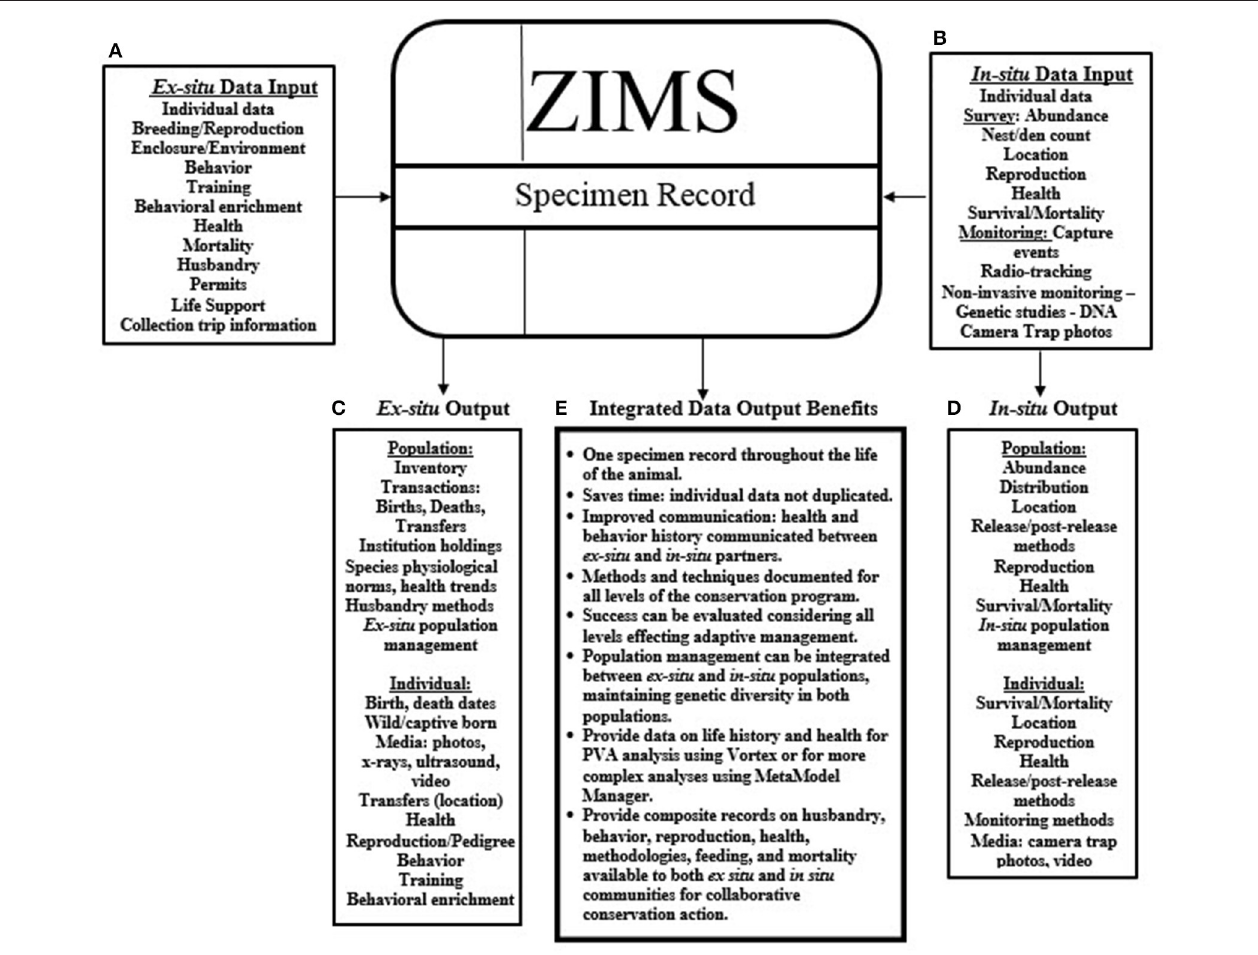
FIGURE 1 | Data management process for a single specimen record in a conservation program with ex-situ and in-situ components. (A) Data for ex-situ input into ZIMS. (B) In-situ data input either in a separate information system or as a continuance of ex-situ specimen record. (C) Output from ZIMS– ex-situ data alone. (D) Output from program databases- in-situ data alone. (E) Benefits of an ex-situ and in-situ integrated system. ZIMS, Zoological Information Management System.